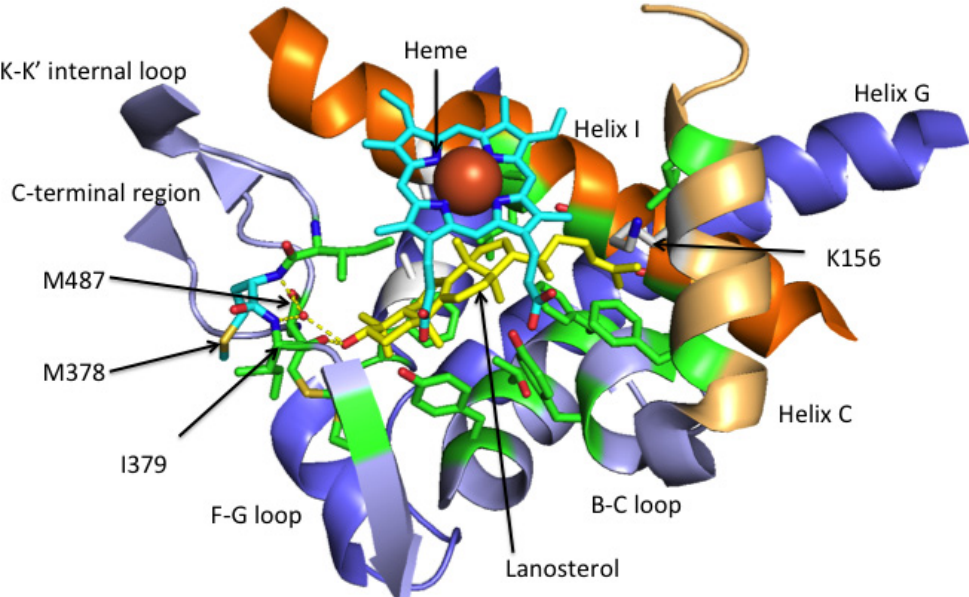
Figure 4. Lanosterol in the ligand-binding pocket (LBP) of CYP51. Relevant portions of the human HsCYP51 crystal structure (Protein Data Bank (PDB) 6UEZ) are shown. Residues within 4 Å of lanosterol (yellow) are shown with carbon atoms in green. These 16 residues are found in helix I, helix B, helix C, the B-C loop, the K-K (cid:48) internal loop and the C-terminal region. Proton channel S mutations, D231A in helix F and H314A in nearby helix I, are shown in white. Upon lanosterol binding helix C has changed conformation slightly, the K156 side chain loses its ionic interaction with the heme propionate C and becomes exposed into the enzyme surface. The K-K (cid:48) internal loop I379 main chain carbonyl hydrogen bonds with the OH of lanosterol. The main chain amides of M378 and I379 plus the main chain carbonyl of M487 in the C-terminal region form a water-mediated hydrogen bond network with the hydroxyl of lanosterol. The 14 α -methyl group of lanosterol lies in proximity of the heme iron (large red ball) in a catalytically competent